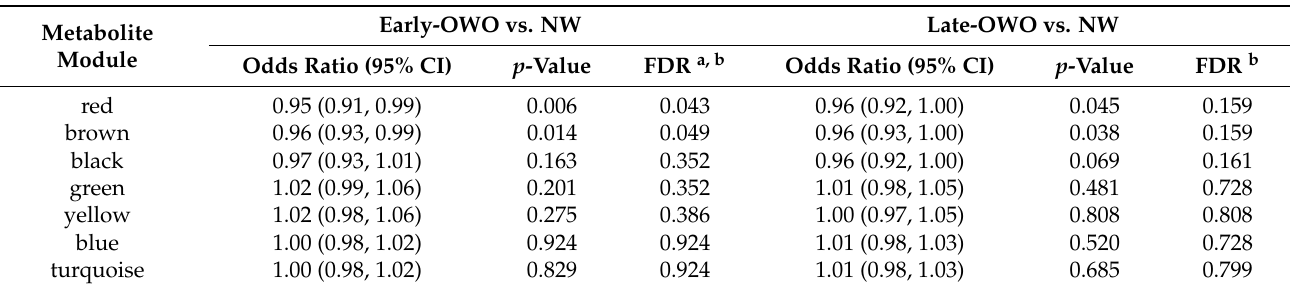
Table 2. Longitudinal trajectory analysis: Associations of cord metabolite modules (as defined based on correlation between metabolite pairs) with child BMI trajectory groups (early-OWO and late-OWO as compared to NW) from multinomial logistic regression model